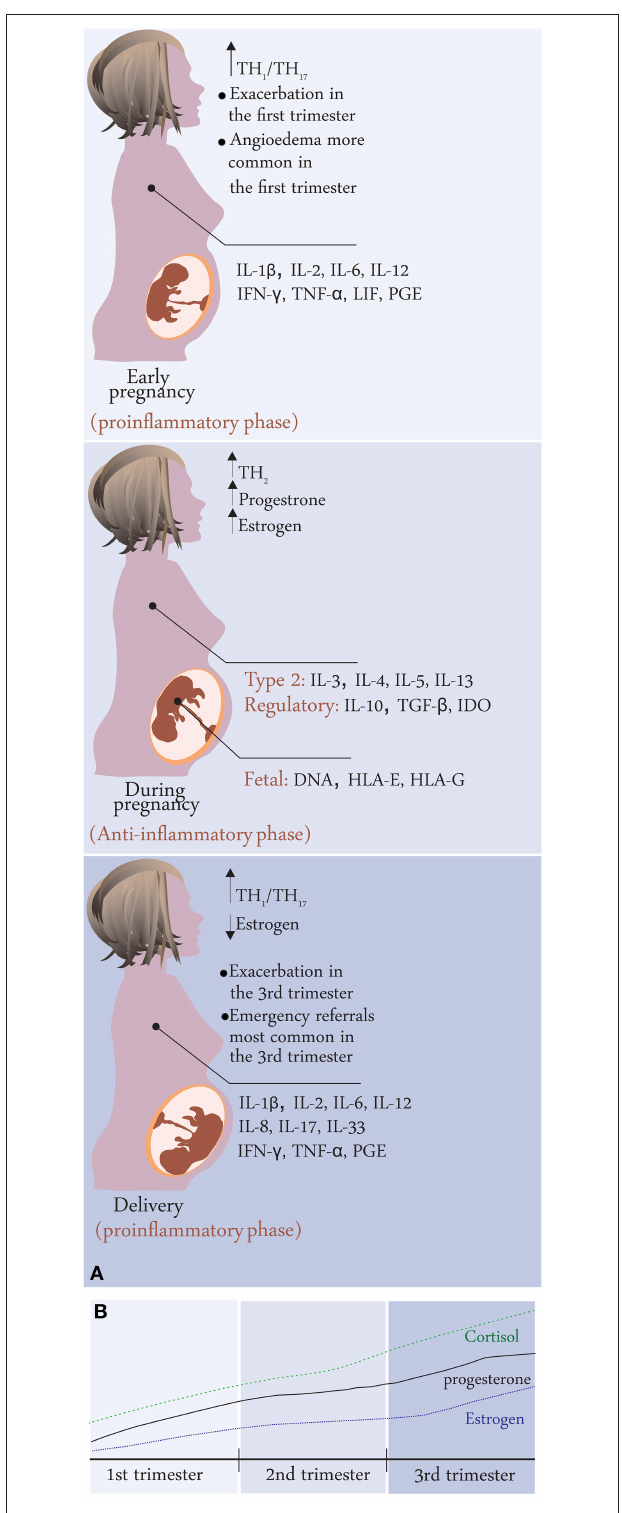
FIGURE 1 | (A) Disease activity changes during pregnancy in CU patients; summary of results from the PREG-CU study with possible mechanisms related to immunological changes in pregnancy. (B) Change in hormone levels during pregnancy.